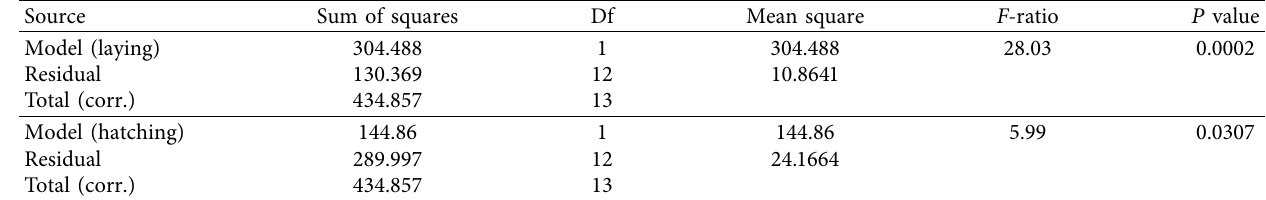
Table 2: General linear statistical model relating nesting, laying, and hatching dates.